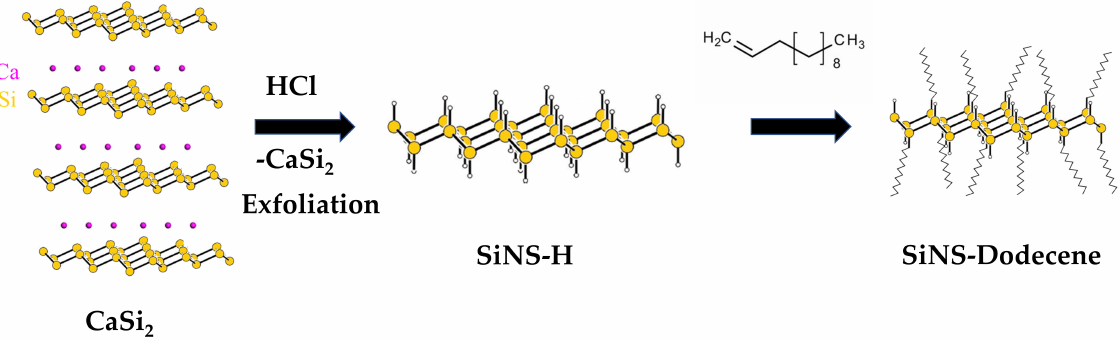
Figure 1. Schematic representation of SiNS–H synthesized by chemical exfoliation from CaSi 2 and SiNS–dodecene obtained via hydrosilylation reaction with